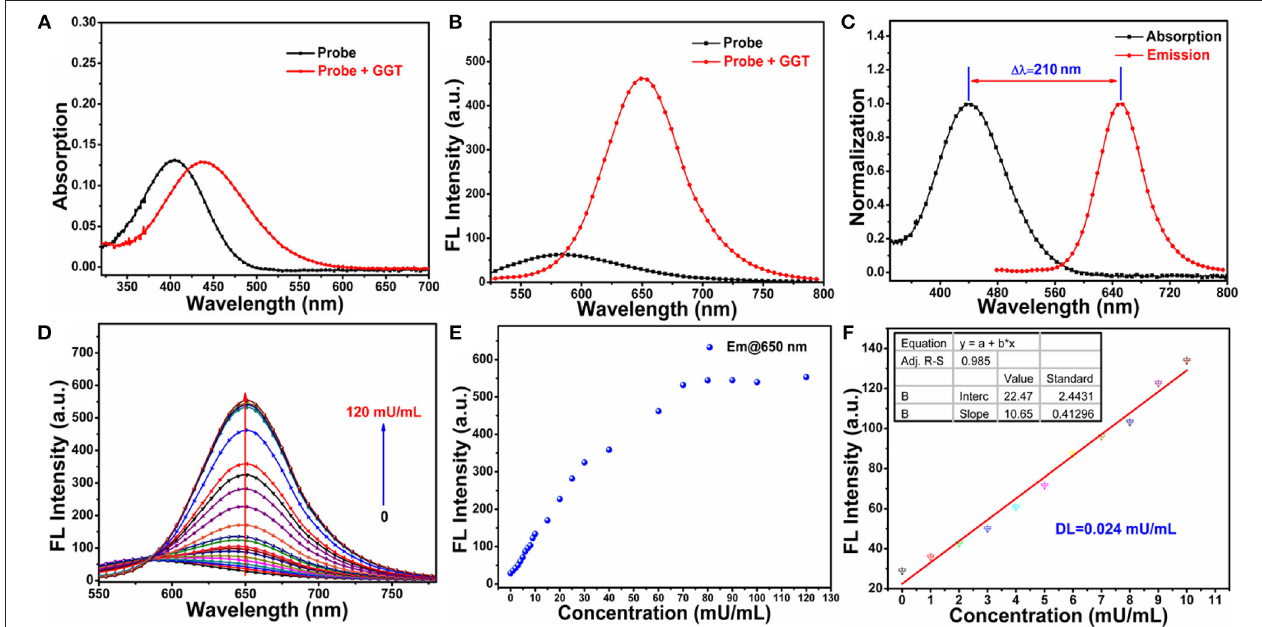
FIGURE 1 | (A) UV-Vis and (B) fluorescence spectra changes of probe NIR-SN-GGT (10 µ M) toward adding 60 mU/mL γ -GGT enzyme in PBS buffer solution (0.01M, pH 7.4). (C) Normalization UV-Vis (blank line) and fluorescence spectrum (red line) of NIR-SN-NH 2 in PBS buffer solution (0.01M, pH 7.4). (D) Fluorescence titration experiments of probe NIR-SN-GGT (10 µ M) toward different concentrations of γ -GGT enzyme (titration concentrations: 0, 1, 2, 3, 4, 5, 6, 7, 8, 9, 10, 15, 20, 25, 30, 40, 60, 70, 80, 90, 100, 120 mU/mL). (E) Fluorescence intensities of probe NIR-SN-GGT (10 µ M) around 650nm toward various concentrations of γ -GGT enzyme (0-120 mU/mL). (F) The linearity of F 650nm vs. low concentration of γ -GGT ranging from 0 to 10 mU/mL. The experiments were repeated three times and the data were shown as mean ( ± S.D.). λ ex = 445nm, slit: 10/10nm.